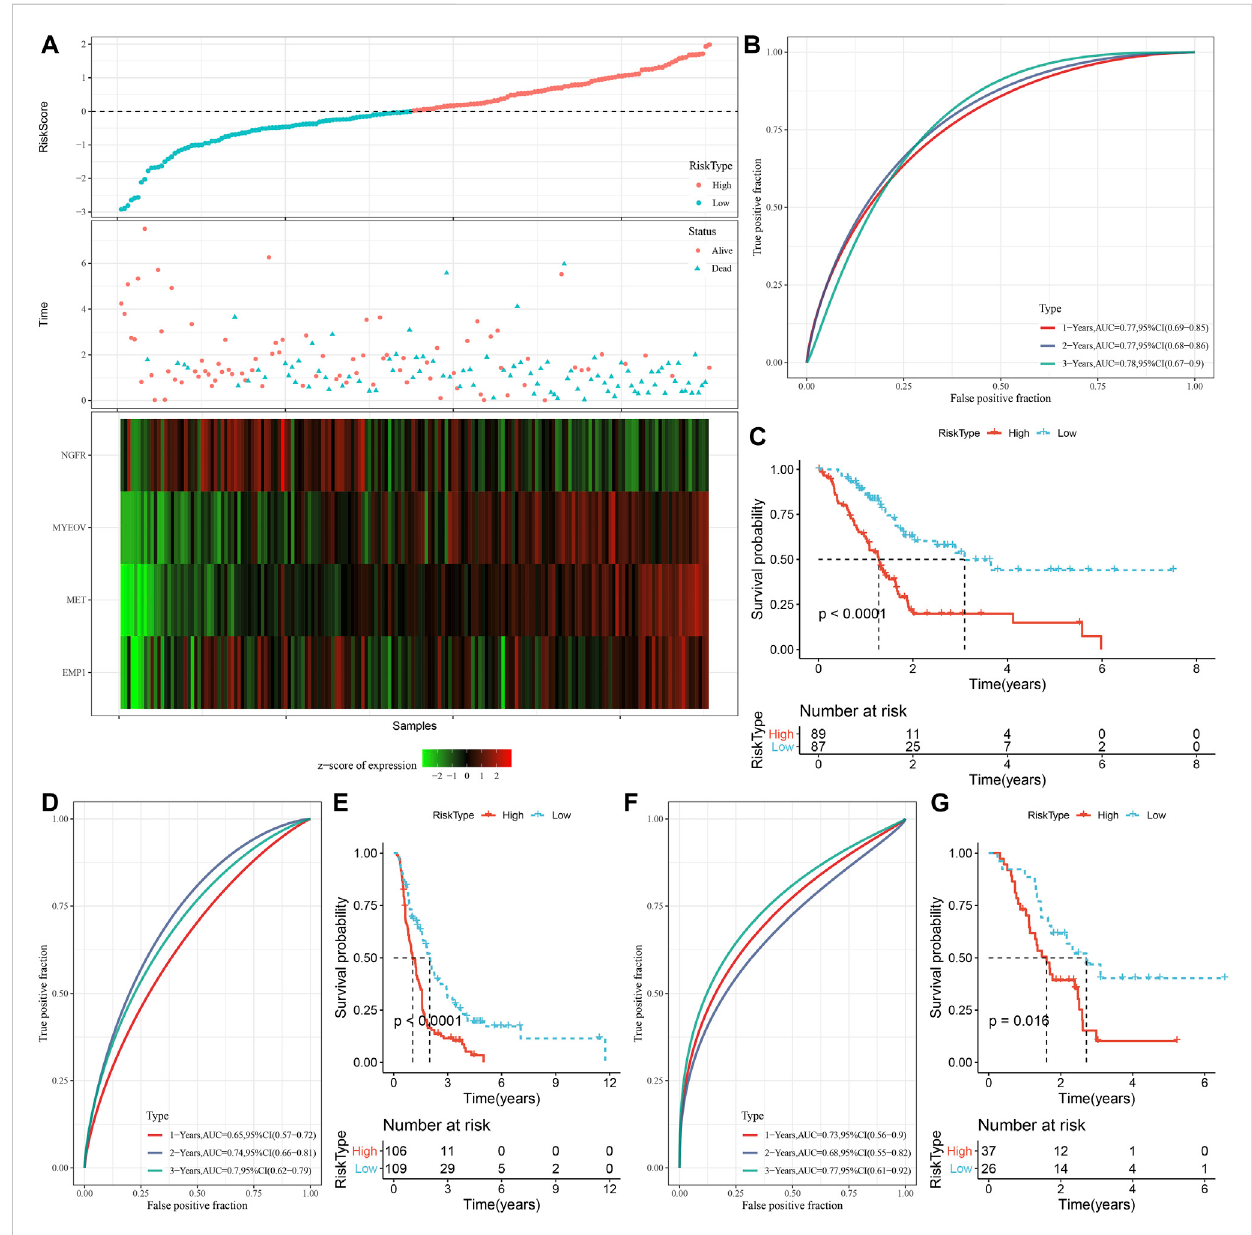
FIGURE 8 Construction and validation ofthe prognosismodel for PC. (A) The risk scores ofpatients inthe TCGA cohort. (B) The ROC results of the prognostic model in the TCGA cohort. (C) The survival analysis results of the prognostic model in the TCGA cohort. (D, E) ROC curve and KM survival curve of risk score in PACA-CA cohort; (F, G) ROC curve and KM survival curve of risk score in GSE57495